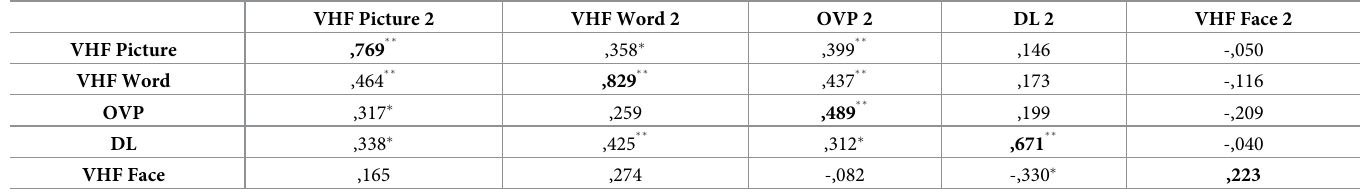
VHF = Visual half field; OVP = Optimal Viewing Position; DL = Dichotic Listening (using indices based on left/right ear matches). �� denote significant correlations at the 0.01 level (2-tailed) � denote significant correlations at the 0.05 level